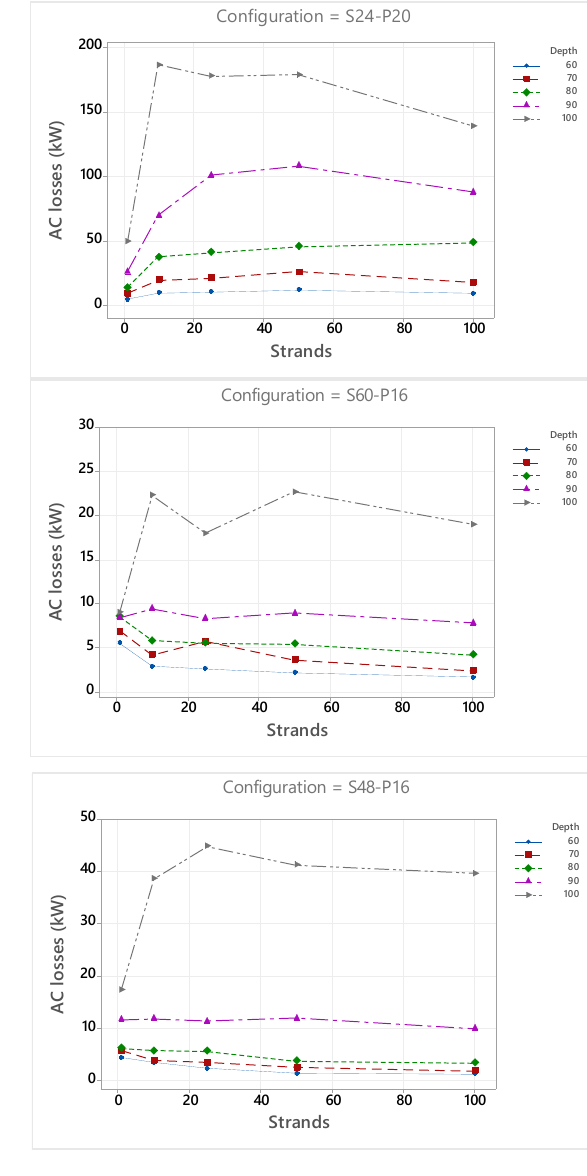
Figure 8. Stranding effect on AC loss map. As these motors have a common design characteristic of open slots, the losses at 100% depth are very high; this is specifically very dominant in the case of multi-strands. This